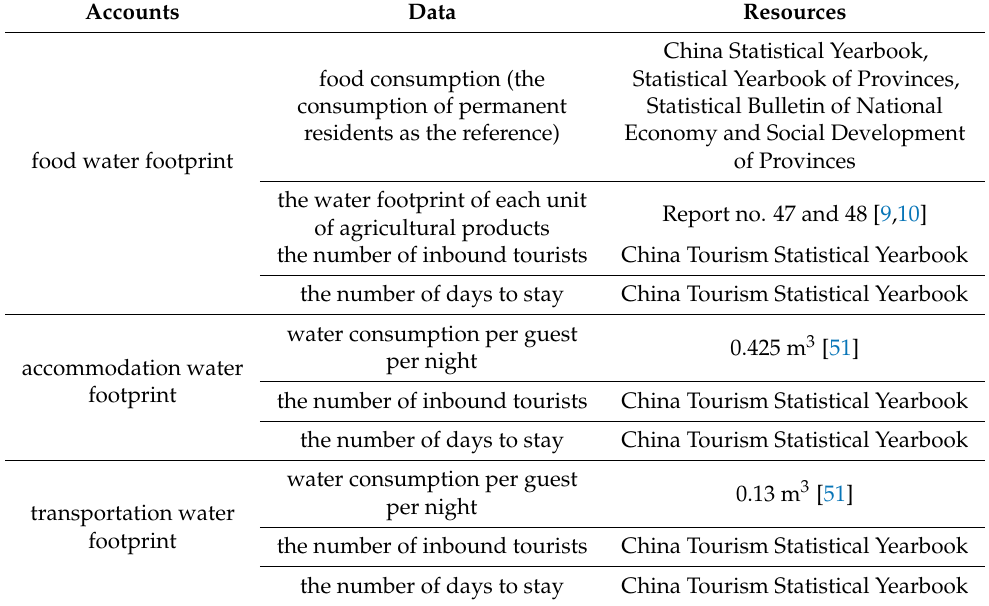
Table 1. A summary table of the data